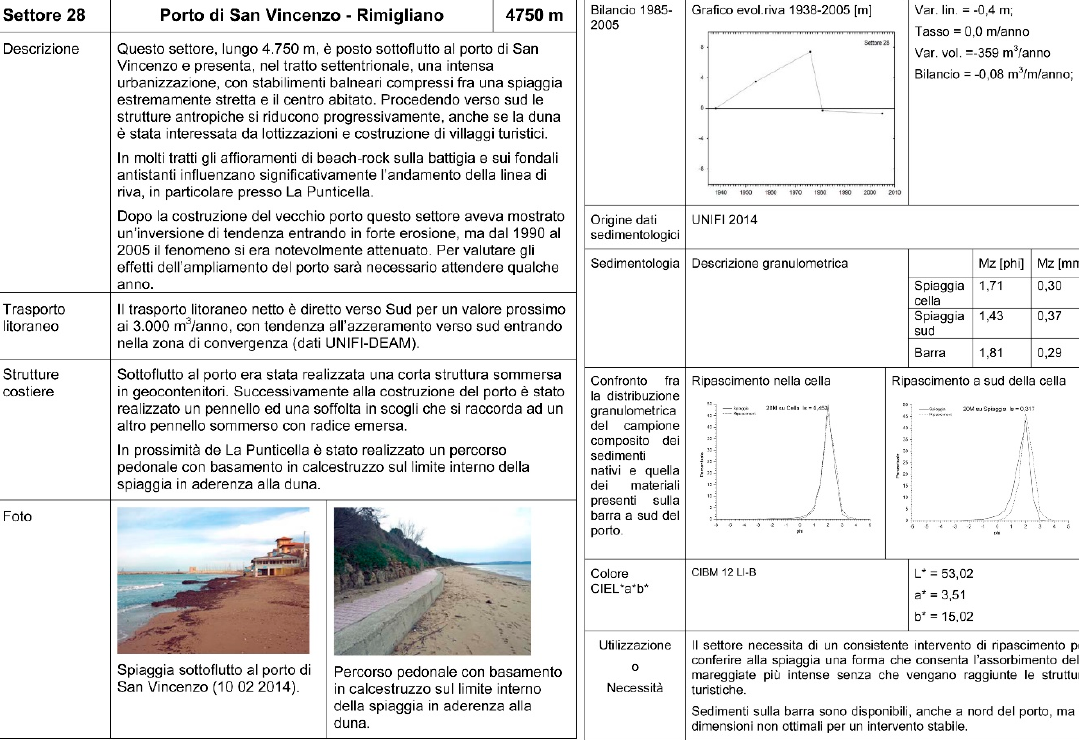
Figure A1. One out of the 56 forms (this is in two pages) reporting information on the sectors in which the Tuscan coast was divided to assess sediment budget, sand characteristics and potentials/needs for artificial nourishment (in Italian, like the original).